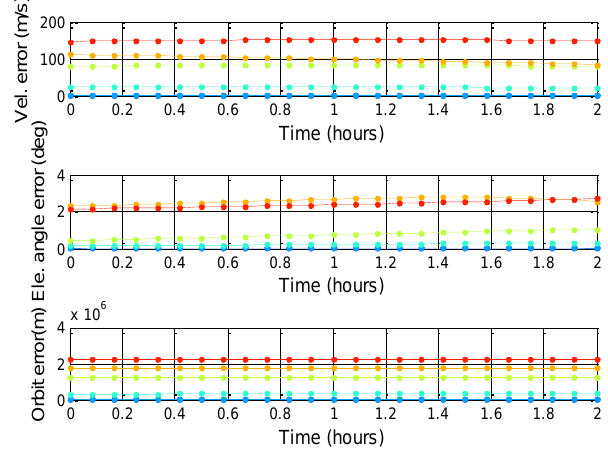
Figure 23. BDS DQA1: BDS IGSO almanac using period test for five weeks.